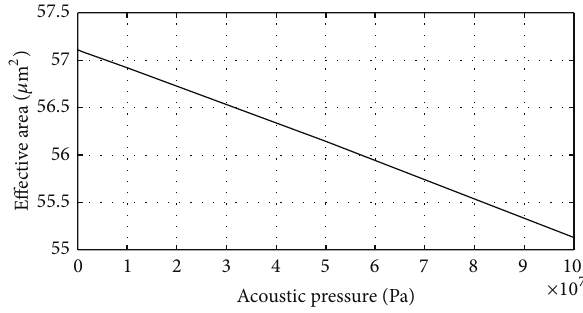
Figure 3: The calculated fundamental mode refractive index of the investigated HC-PBF as a function of the acoustic pressure at acoustic frequency 10 kHz.